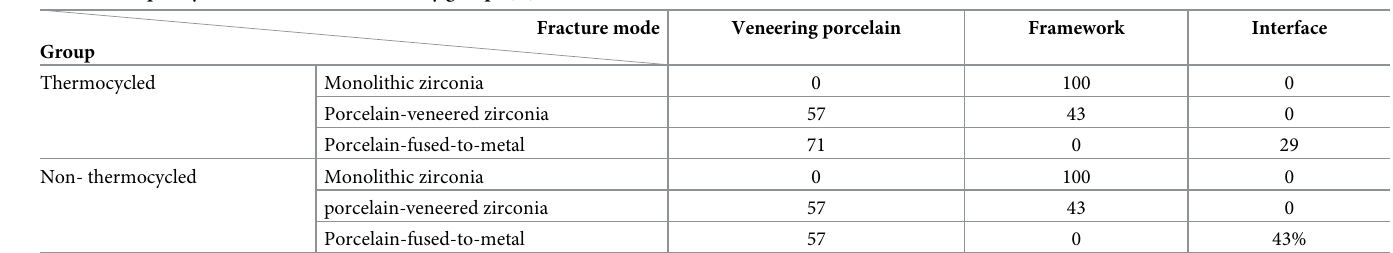
Table 3. Frequency of failure modes in the study groups